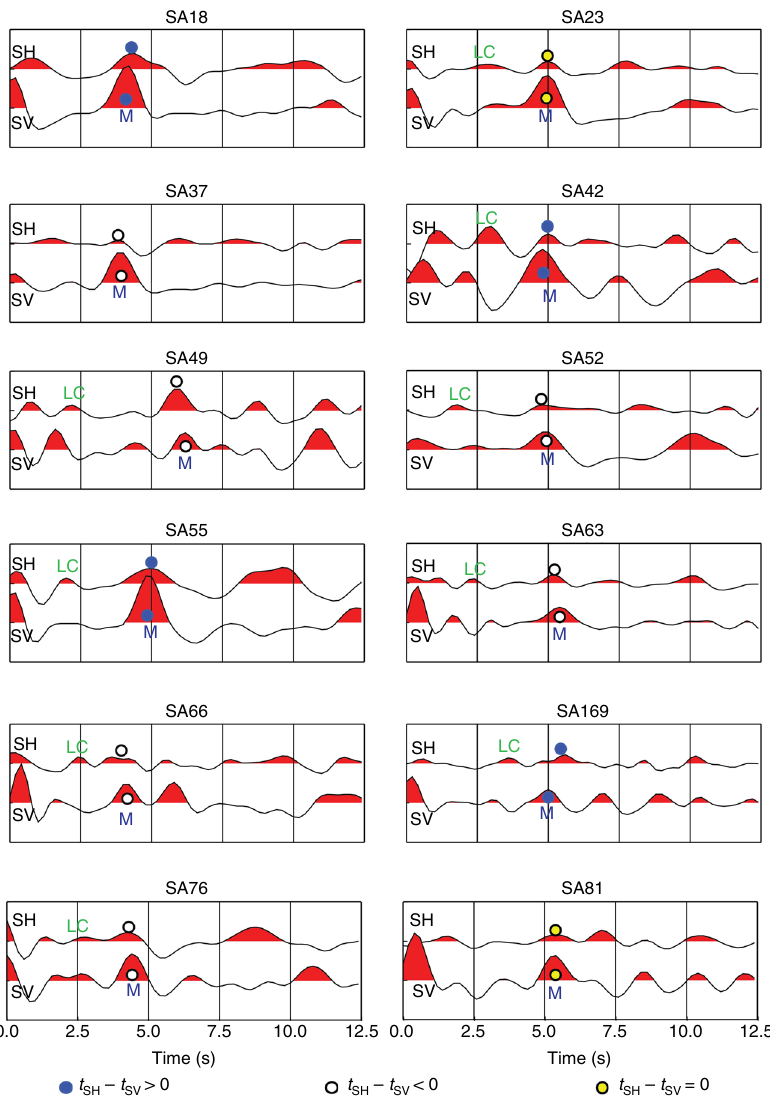
t SH – t SV < 0 Fig. 3 Stacked transverse (P SH ) and radial (P SV ) receiver functions used to calculate the amplitude ( δ t ) of crustal anisotropy (cf. Supplementary Table 1). Only positive amplitudes were stacked; otherwise, the resulting stack would be close to zero amplitude due to the polarity changes incurred by anisotropy. The examples are from Kaapvaal Craton (SA18, 37, 42, 49, 52, 63), Limpopo Belt (SA55, 169), Zimbabwe Craton (SA66, 76), Kheis Belt (SA23) and Namaqua – Natal Belt (SA81). M and LC denote conversions from the Moho and top of the lower crust, respectively. Notice the change in relative arrival times of the transverse P SH - and the radial P SV -RFs between the two cratons and the Limpopo ( φ ) in the lower and upper crust. The 2 π periodicity of the LC and M phases and the π /2 phase lag between the radial P SV and transverse P SH components of the LC phase show that the symmetry axis of the anisotropy cannot be horizontal 36 – 38 . In western Zimbabwe Craton, the direction of the fast polarisation axes is less uniform between 50 and 70° (Supplementary Table 1).